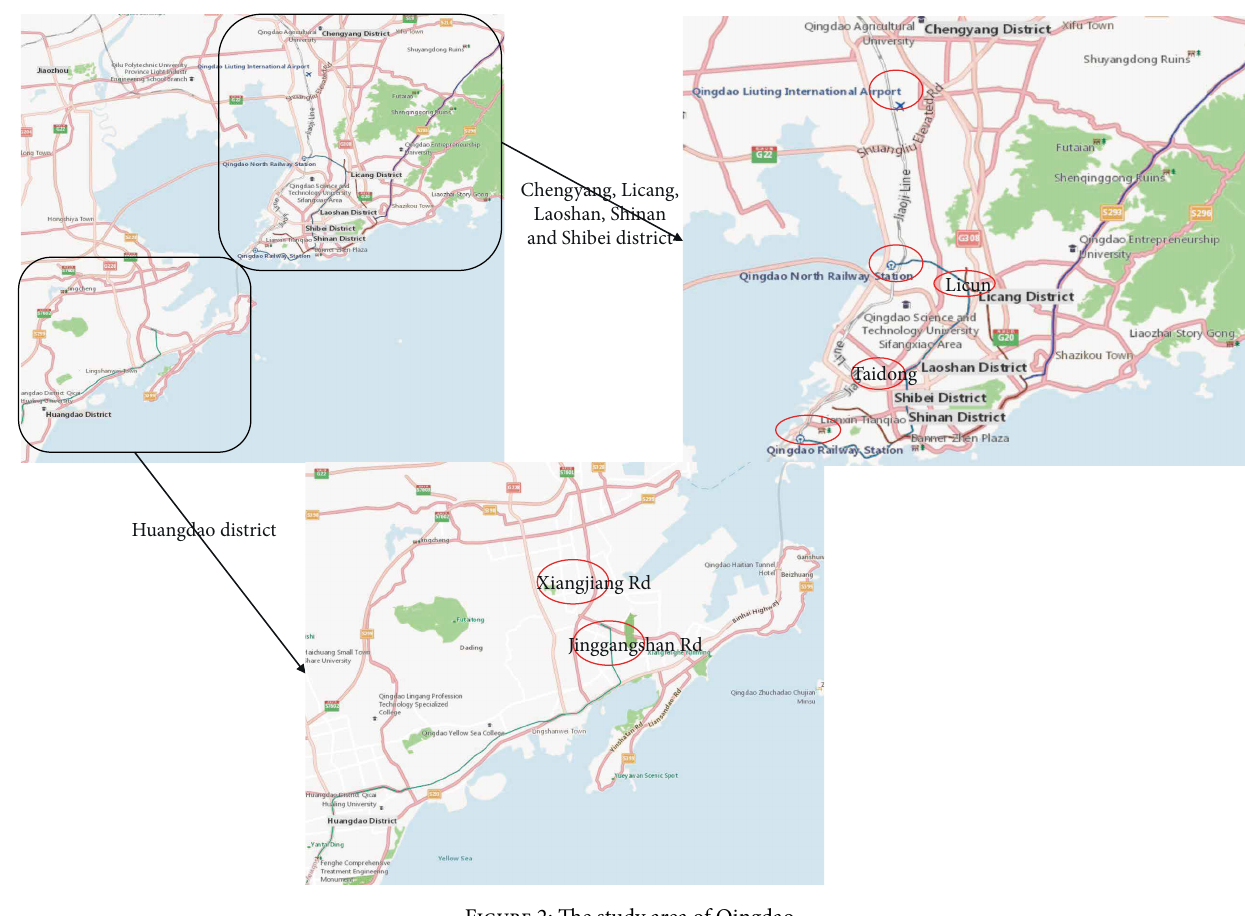
Figure 2: The study area of Table 1: Candidate list of explanatory variables.